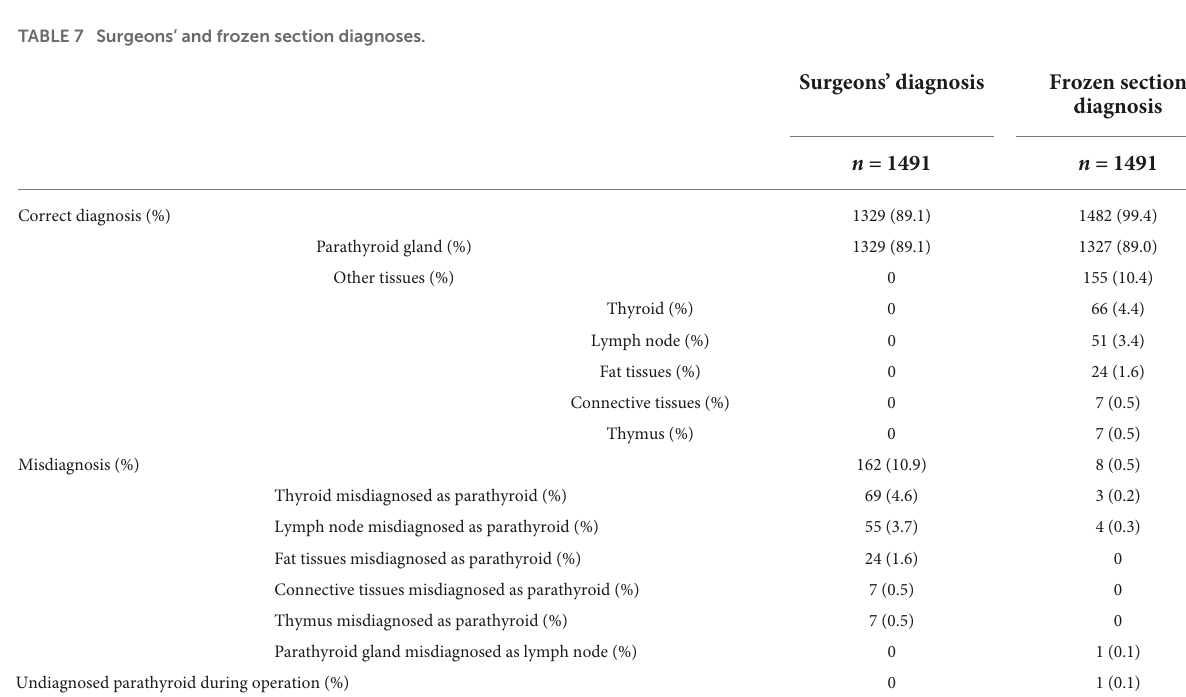
TABLE 7 Surgeons’ and frozen section diagnoses.